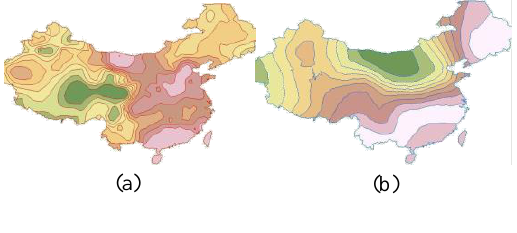
Figure 4. Classification and vectorization of mean annual temperature and mean relative humidity (a) mean annual temperature; (b) mean relative humidity.